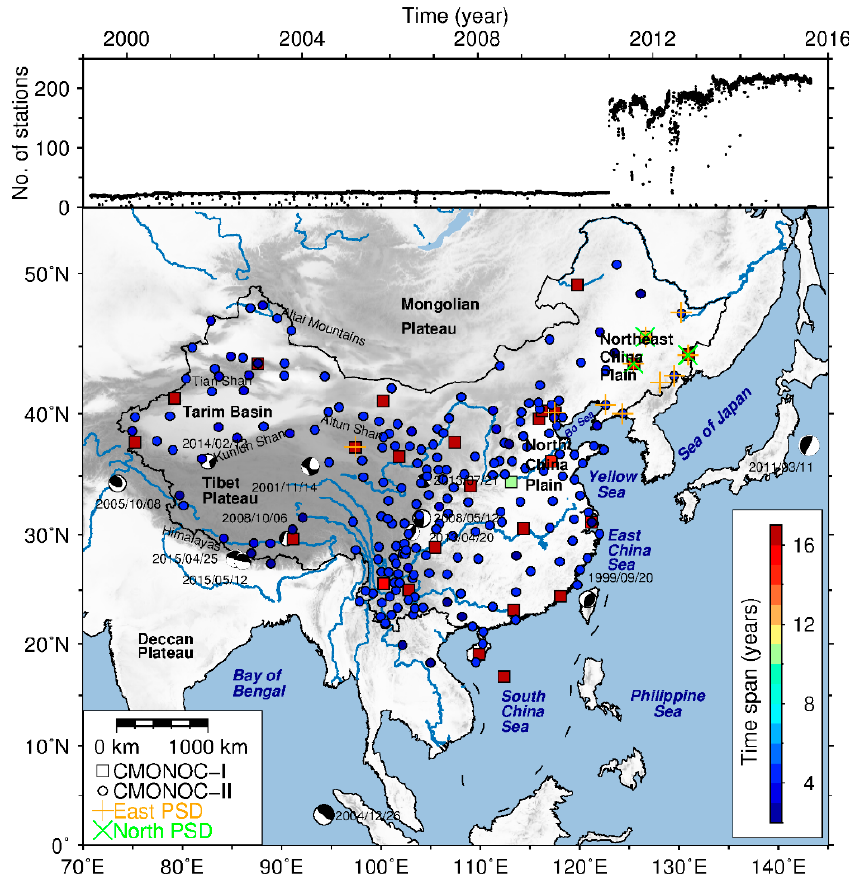
Figure 1. Location map of the selected 231 continuous GPS stations investigated in this study. Squares and circles indicate CMONOC-I and CMONOC-II stations, respectively. Plus and multiplication signs indicate stations with their east and north components affected by post-seismic deformation (PSD), respectively. Several earthquakes in China and surrounding regions are plotted with information from the Global CMT Catalog Search (http://www.globalcmt.org/CMTsearch.html [51,52]).